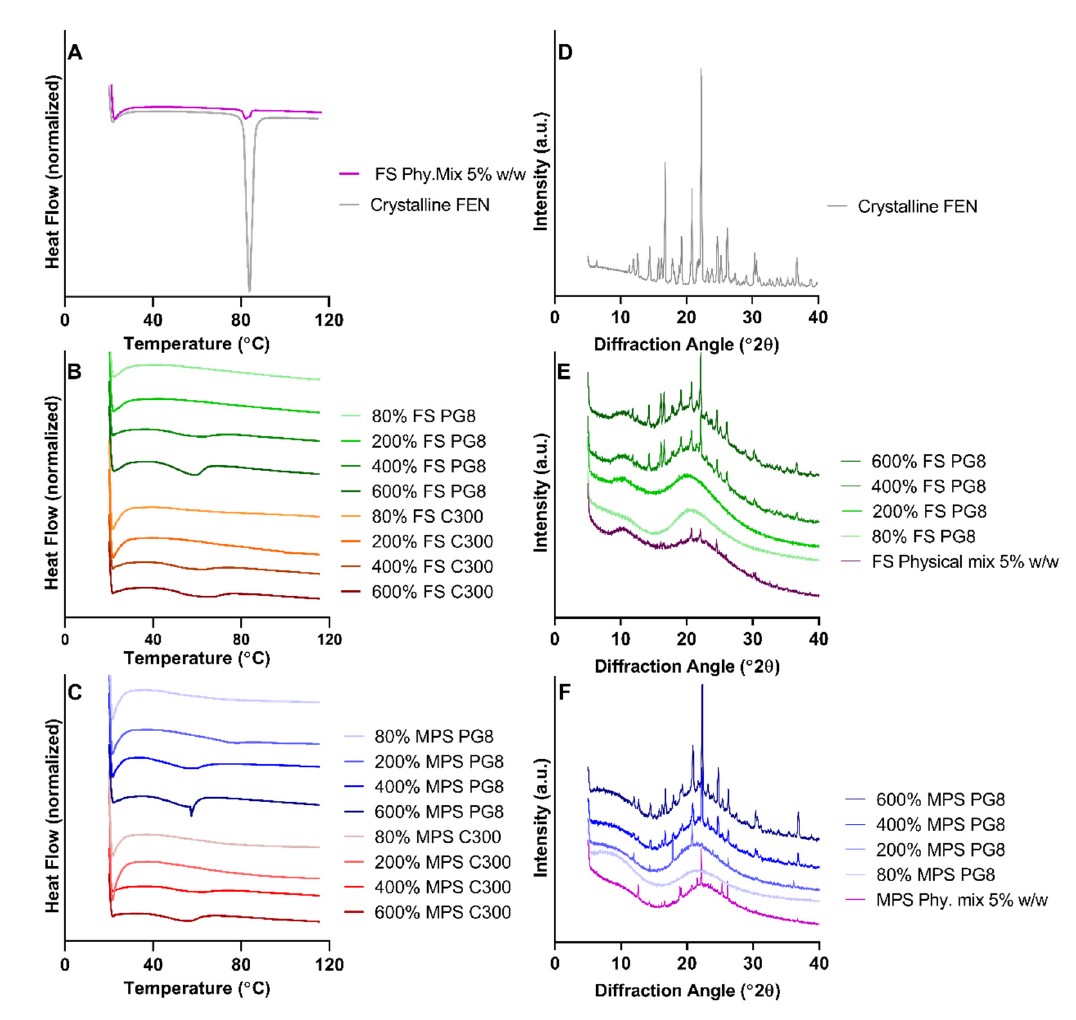
Figure 2. Differential scanning calorimetry (DSC) thermograms of ( A ) crystalline FEN and fumed silica (FS) physical mix 5% w/w , ( B ) FEN-loaded FS formulations and ( C ) FEN-loaded mesoporous silica (MPS) formulations. The X-ray powder diffraction (XRPD) diffractograms of ( D ) crystalline FEN, ( E ) FS PG8 formulations and ( F ) MPS PG8 formulations.